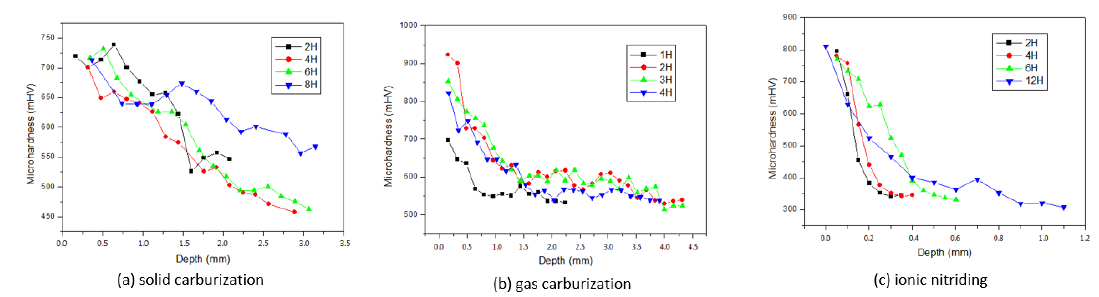
Figure 3 – Hardness profile of P20 steel treated by (a) solid carburization, (b) gas carburization and (c) ionic